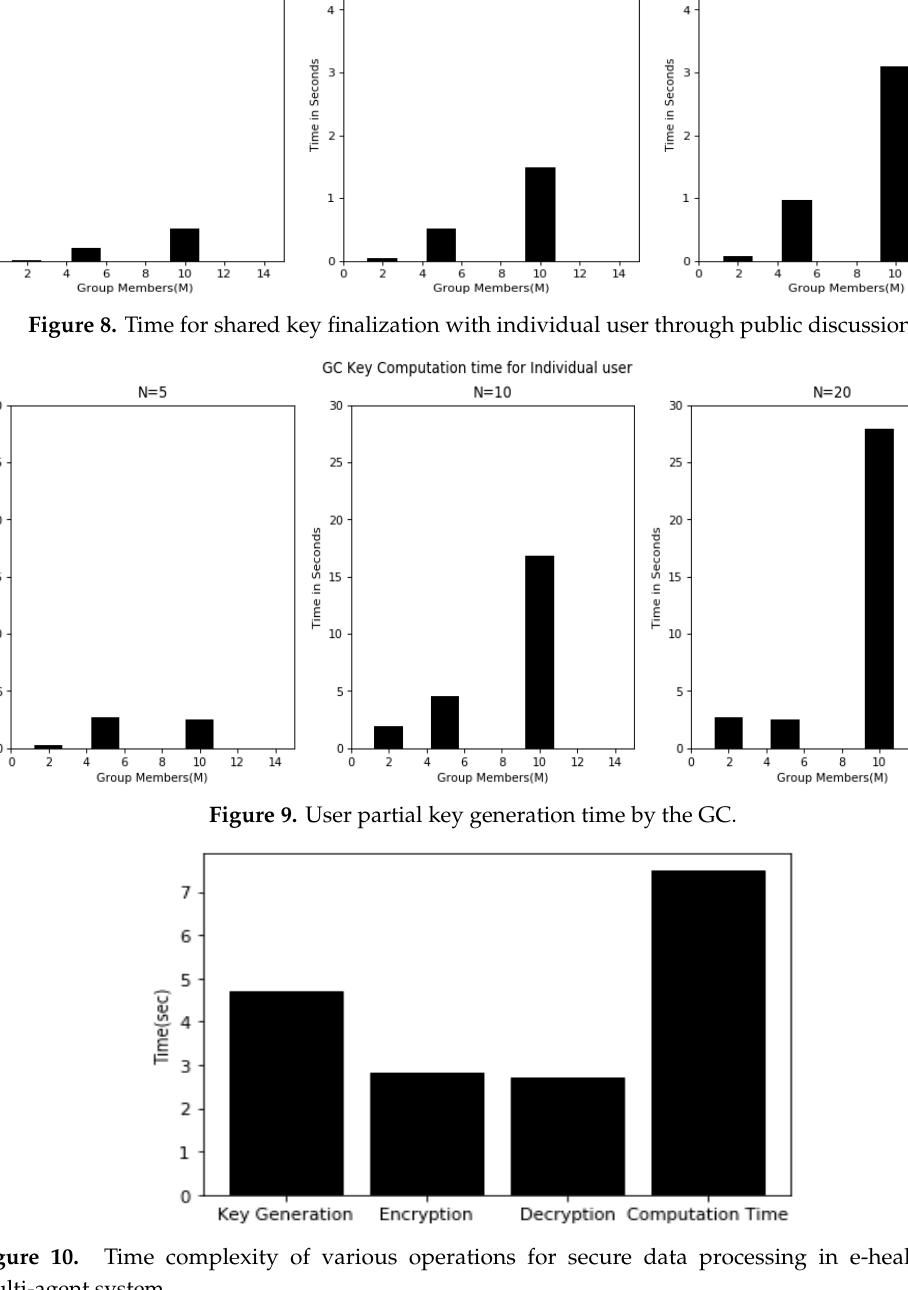
Figure 10. Time complexity of various operations for secure data processing in e-healthcare multi- agent system.